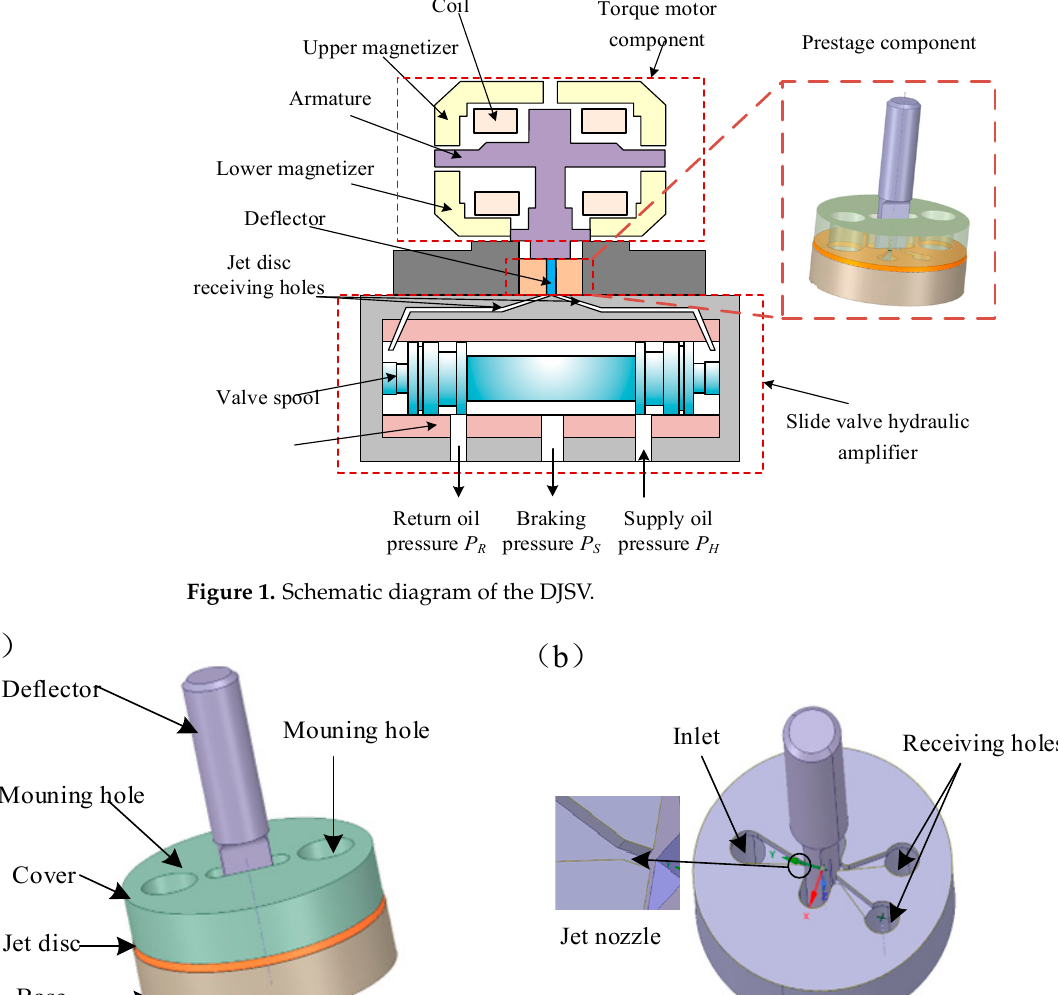
Figure 2. The structure of prestage component ( a ), and the oil channel in jet disc and base ( b ).